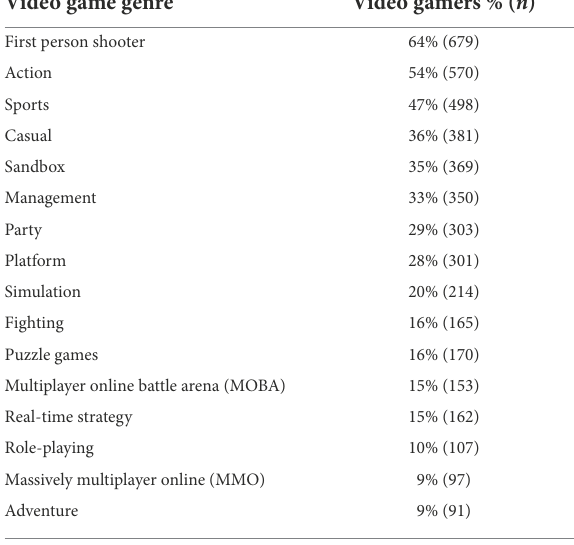
TABLE 4 Prevalence of video gamers at each video game genre in Study 2 ( n = 1,064).